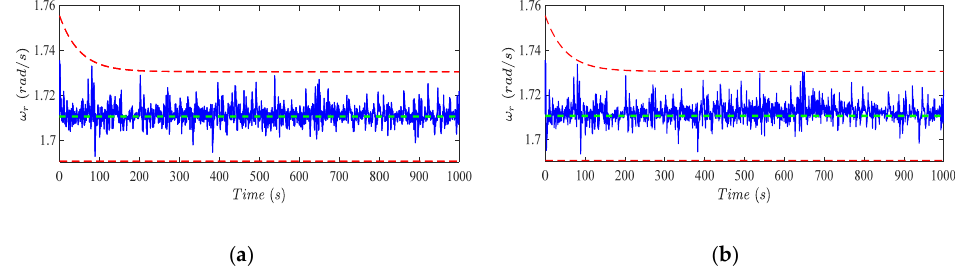
Figure 6. Rotor speed ω r (blue line) with constructed constraints (red dashed lines) and nominal value (green dashed line), under single ( a ) and simultaneous faults (b).